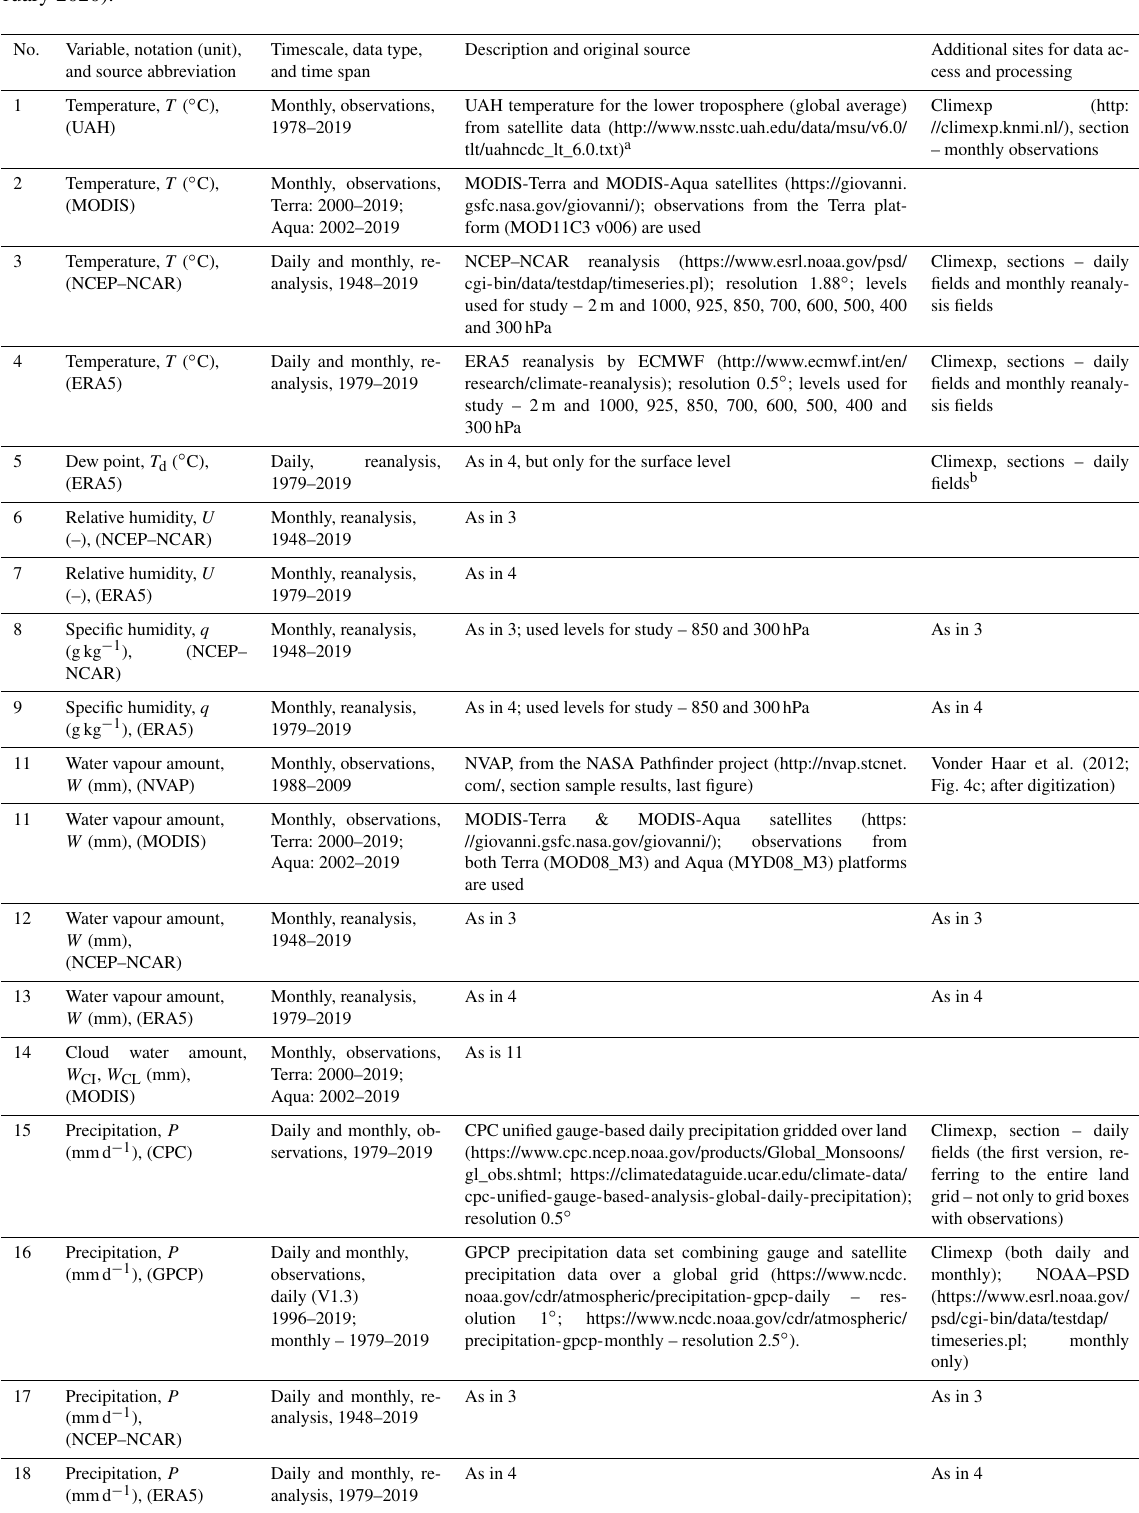
Table 1. List and details of variables and data sets used in the study (unless otherwise stated in a particular entry, all data were last accessed in February